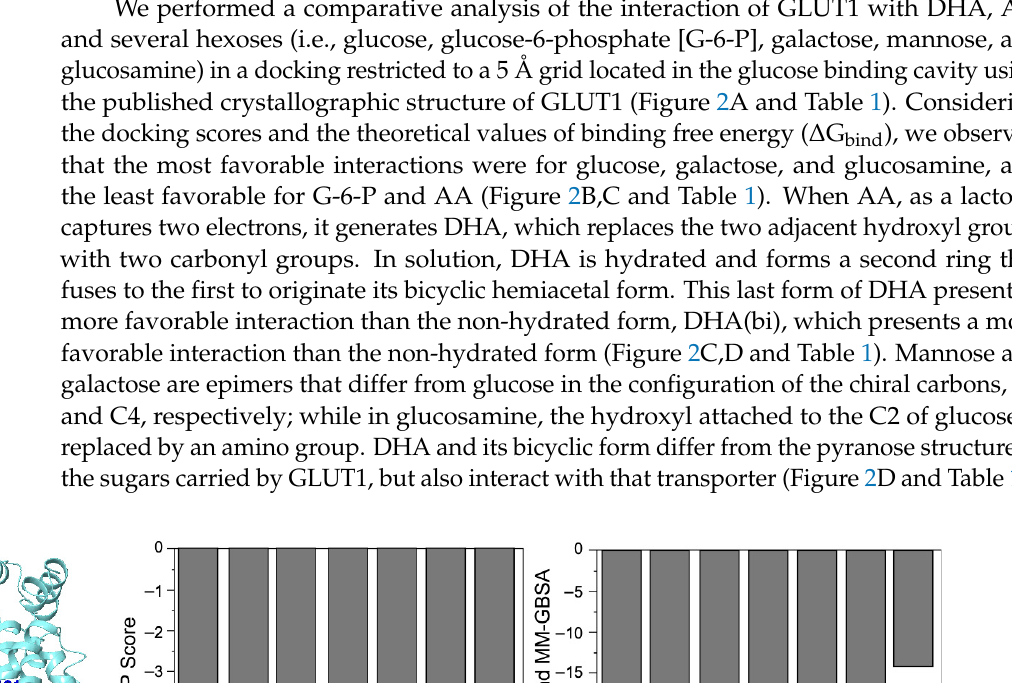
Figure 1. Schematic general model for members of the GLUT family. The conserved signature se- quences appear in boxes, conserved residues in white circles, and high conserved residues in gray circles. The N-linked glycosylation site of Class I is indicated in green. The schema is based on the new GLUT1 crystal structure [24].